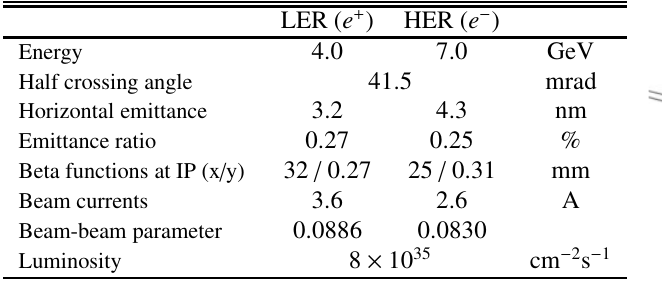
Table 1. SuperKEKB: parameters of the low energy (LER) and high energy (HER) accelerator rings.